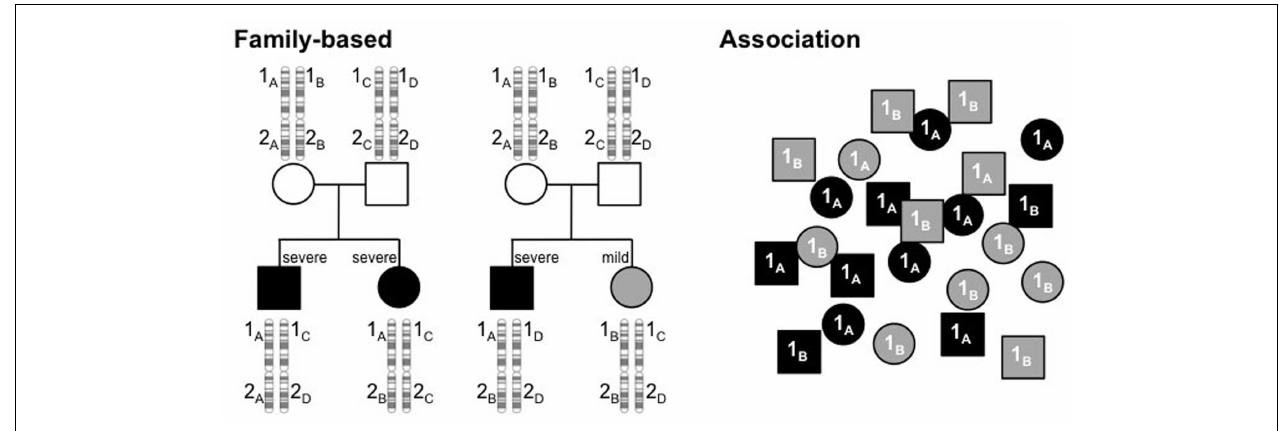
relationship at polymorphism 2. Association studies examine a population of unrelated individuals to determine if particular alleles of a polymorphism are found in different proportions, depending on the disease profile. In the example here, alleles 1 A and 1 B have equal frequencies in the population, but 1 A is much higher in the severely affected subjects (black) and 1 B higher in the mildly affected subset